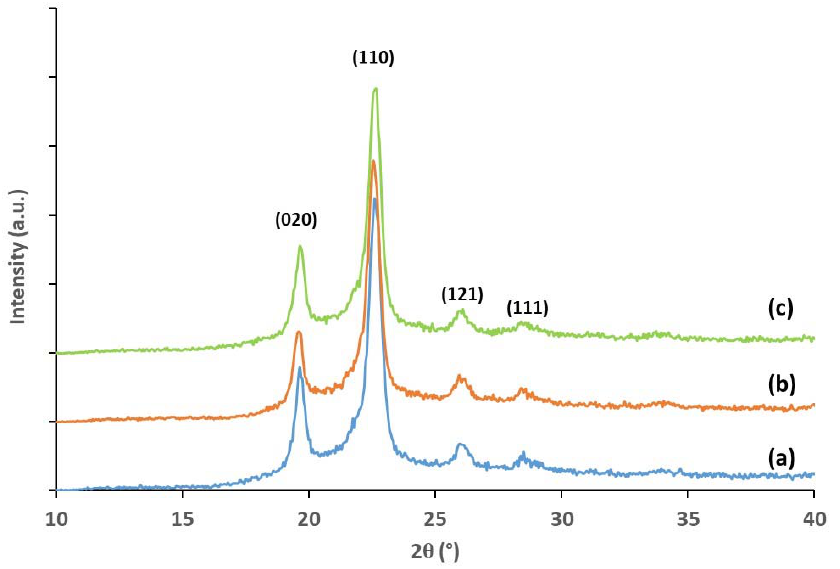
Figure 8. XRD spectra of PBS ( a ) untreated, ( b ) O 2 ‐ plasma ‐ treated for 30 s, and ( c ) O 2 ‐ plasma ‐ treated for 30 s and Ar post ‐ crosslinking for 120 s.